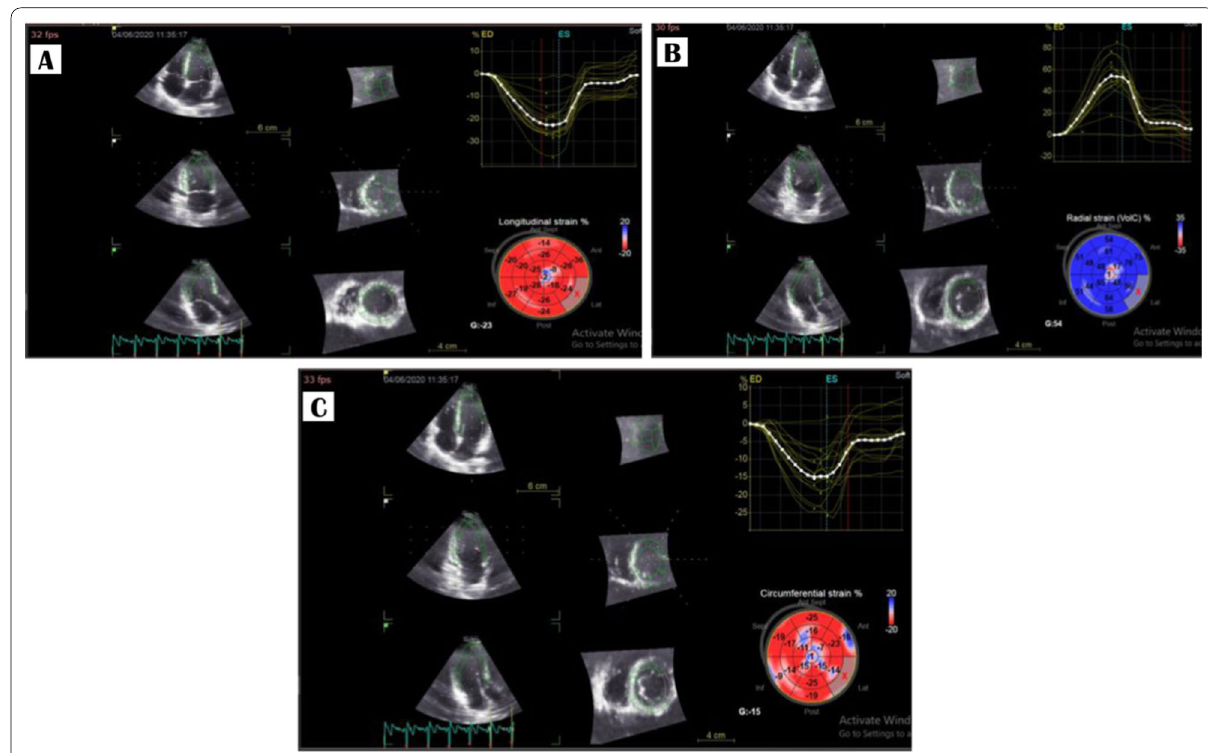
Fig. 1 Three-dimensional (3D) tracing of the left ventricle (LV) to estimate A global longitudinal strain (GLS). B Global radial strain (GRS). C Global circumferential strain